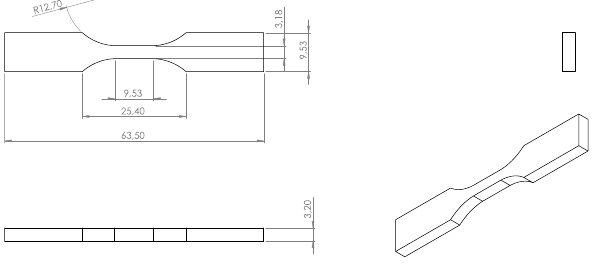
Figure 3: Sketch of the Type V ASTM D638